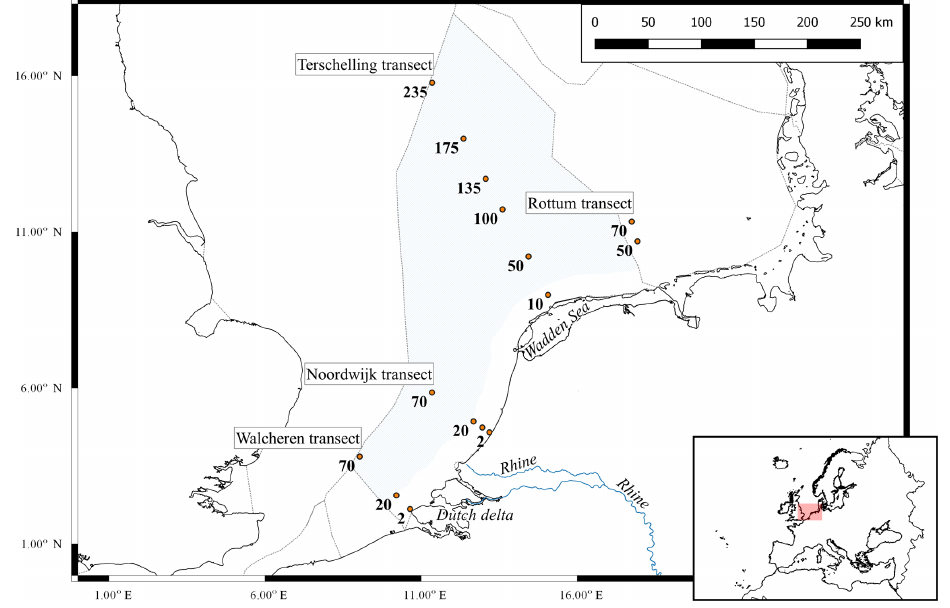
Figure 1. Sampling locations of the MWTL monitoring program referred to in this study. The stations are named according to the transect (Terschelling, Noordwijk, and Walcheren), followed by the number of kilometers from the coast (labels next to sampling points). The boundaries of the Exclusive Economic Zone (EEZ) are indicated by the grey dotted lines, and the Dutch EEZ is colored light blue. The locations of three major inflows to the Dutch North Sea are named at the corresponding locations (the Rhine, Dutch delta, and the Wadden Sea). The inset visualizes the location of the Dutch North Sea in a broader map of Europe. Figure made with QGIS v2.14.2 using EEZ zone data from the Flanders Marine Institute